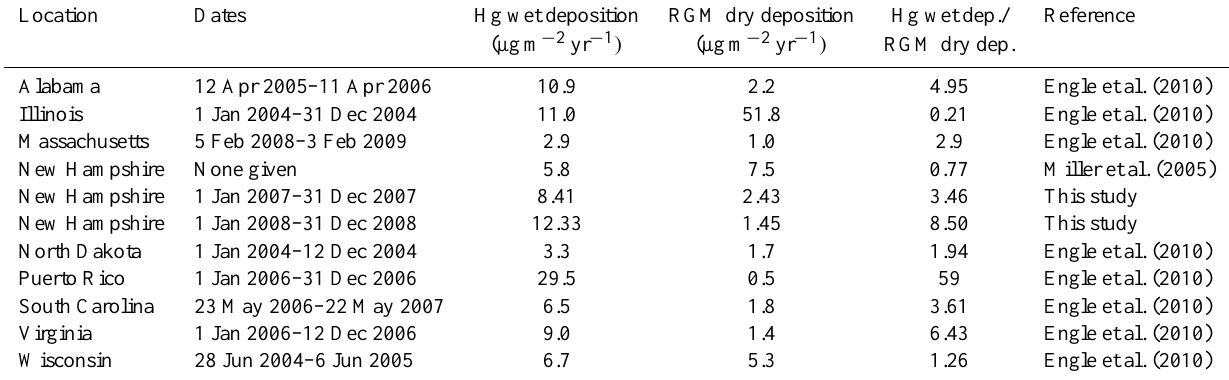
Table 4. A comparison between annual Hg wet deposition and RGM dry deposition values reported in the literature and calculated in this study. Hg wet deposition to RGM dry deposition ratios are calculated from data provided in Engle et al. (2010) and Miller et al.